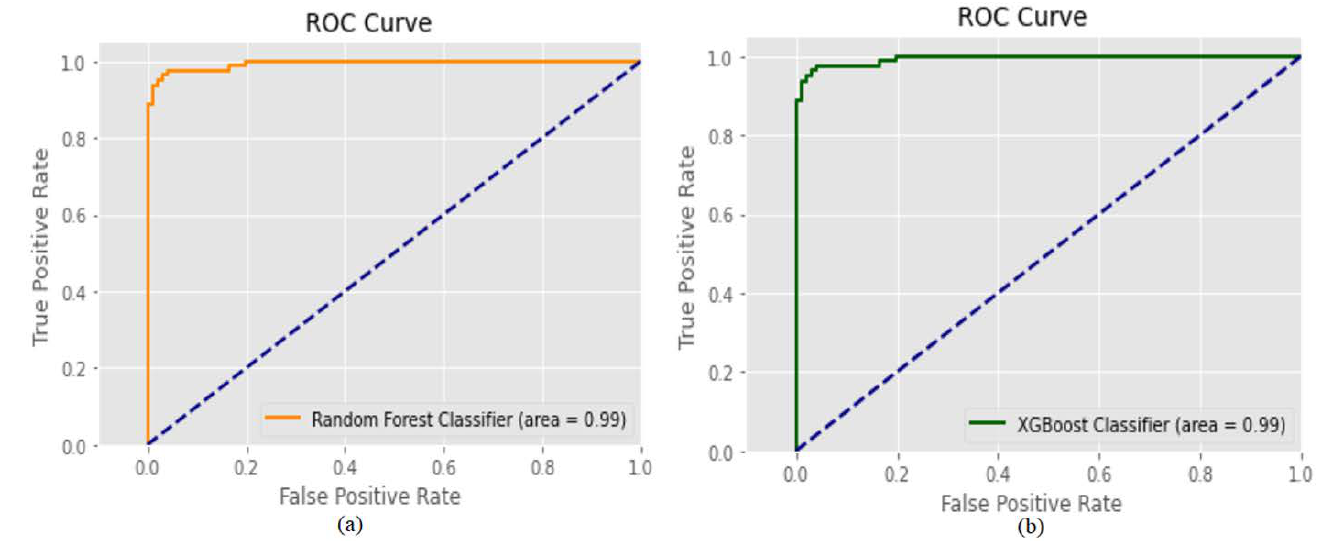
Figure 36. ROC curves for ( a ) RF and ( b ) XG-Boost for bearing fault classification [97].